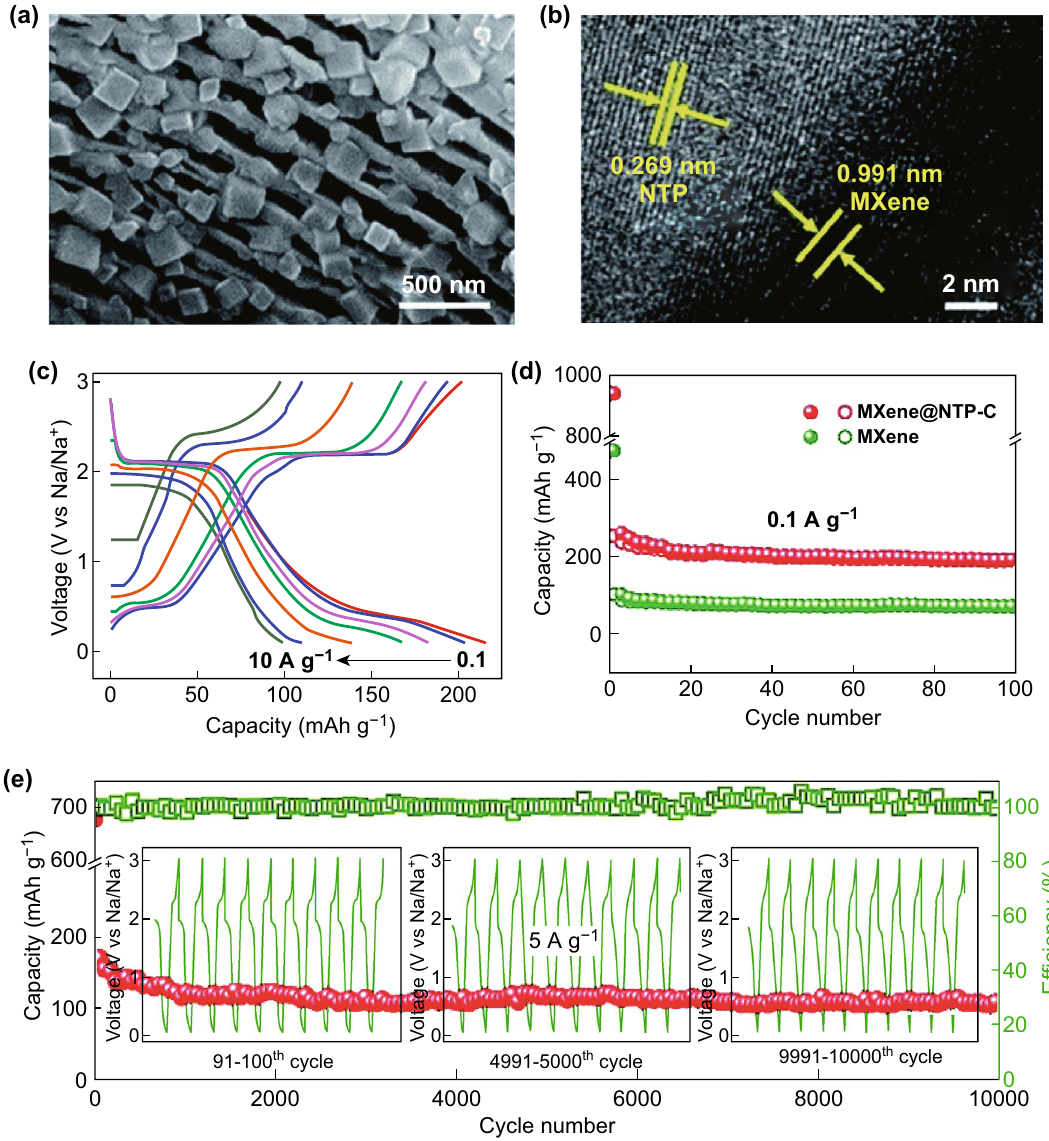
Fig. 7 a TEM and b high-magnification TEM images of MXene@NTP-C. c Galvanostatic discharge/charge profiles of MXene@NTP-C at var- ied current densities of 0.1–10 A g −1 . d Cycling performance of MXene@NTP-C and MXene at 0.1 A g −1 . e Cycling performance of MXene@ NTP-C at high current densities of 5 A g −1 . The inset of e shows the voltage–cycle profile at three different stages [110]. Copyright 2018,